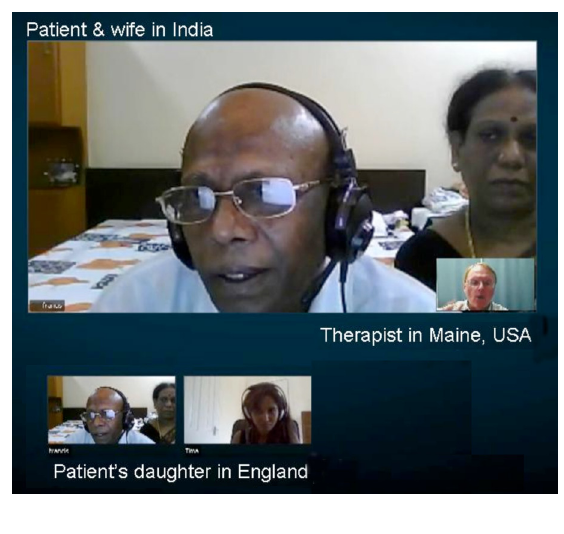
Figure 3: Connecting from Maine USA to India, more than 11493 kilometers away (7143 miles), with secure high definition web-based speech therapy telepractice on personal computers using no special hardware or